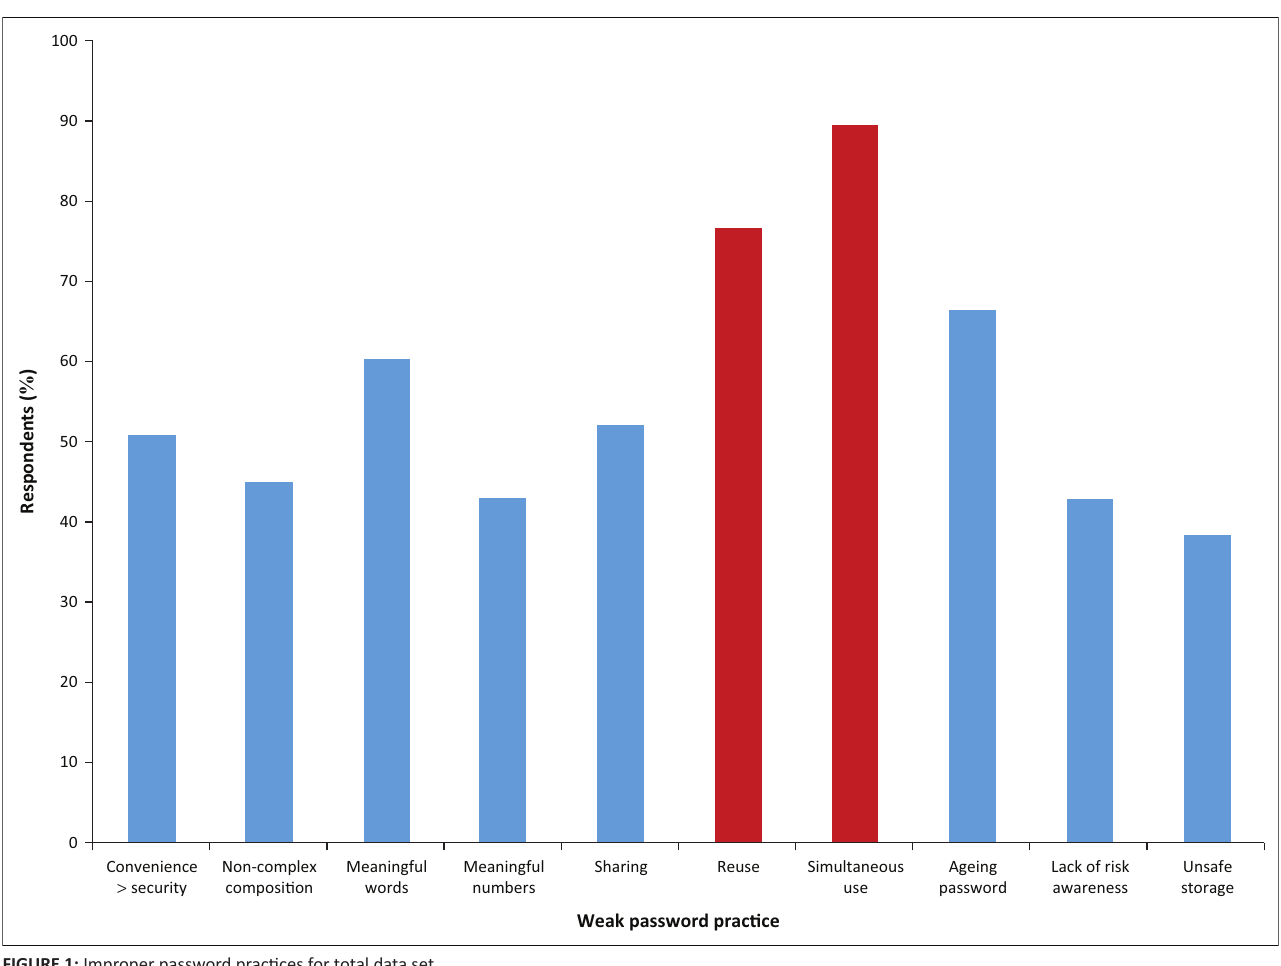
FIGURE 1: Improper password practices for total data